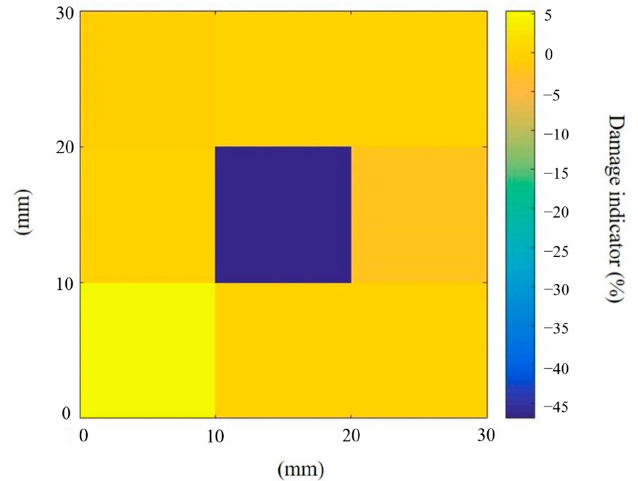
Figure 12. Damage identification results of the damaged segment.